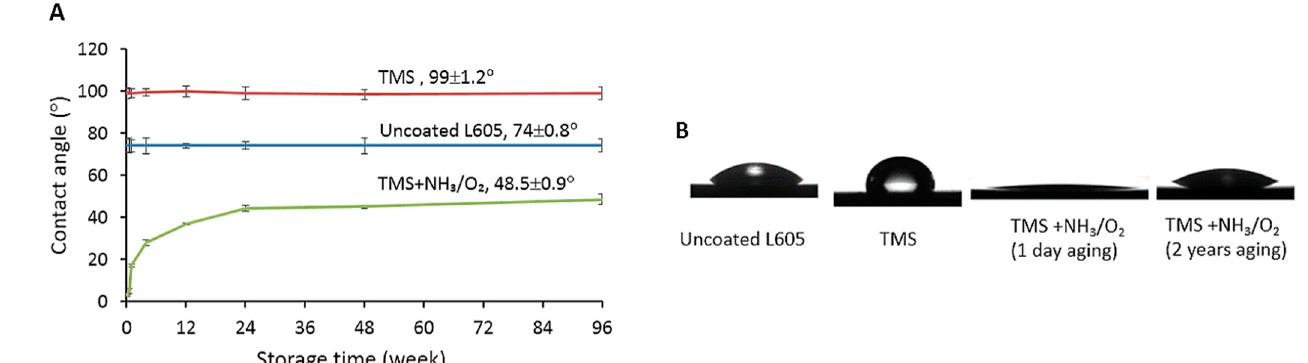
Figure 1. ( A ) Surface static contact angles for uncoated, TMS, and TMS+NH 3 /O 2 plasma-nanocoated L605 coupons up to 96 weeks, n = 6. ( B ) Optical images of spherical water droplets onto uncoated and plasma-nanocoated L605 coupons, n = 3. TMS stands for TMS plasma-nanocoated L605, and TMS+NH 3 /O 2 stands for TMS plasma-nanocoated L605 with NH 3 /O 2 plasma post-treatment. As shown in Figure 2A and Table 1, XPS survey spectrum for uncoated L605 prior to oxygen plasma treatment indicates the presence of N 1s peak, which disappeared after oxygen plasma pretreatment. After oxygen plasma treatment, that N 1s percentage was reduced from 0.81 ± 0.01 at.% to 0 and C 1s declined from 34.98 ± 1.56 at.% to 25.15 ± 2.46 at.% for L605 samples, implying the clean L605 surfaces prior to the TMS plasma nanocoating process. The contamination removal is considered beneficial to the adhesion of plasma nanocoatings to the L605 substrates. The increase of O 1s percentage from 44.7 ± 2.04 at.% to 61.4 ± 3.12 at.% confirms that the L605 surface not only contains O element inherently in its oxide layer, but also O element incorporated by oxygen plasma treatment.